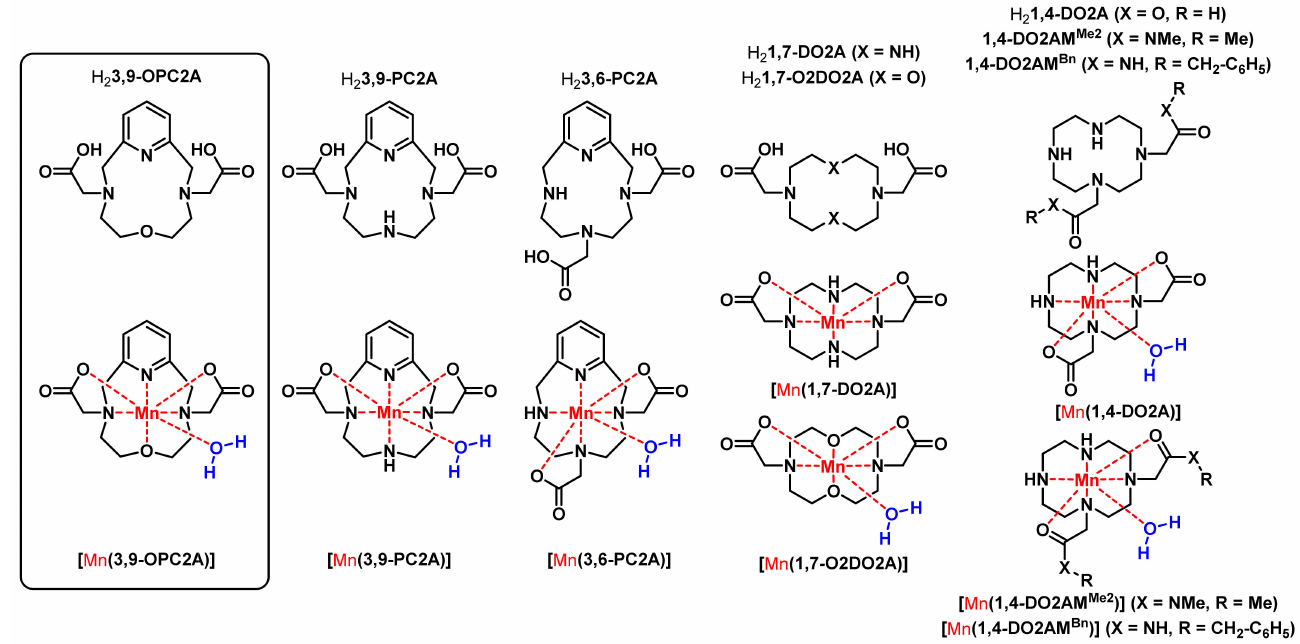
Figure 1. Formulae of the ligands and their Mn(II) complexes, discussed in the present work. Our approach to Mn(II)-based MRI CA candidates is based on the rigid pyclen derivative H 2 3,9-PC2A ligand (H 2 3,9-PC2A = pyclen-3,9-diacetate), as it forms a